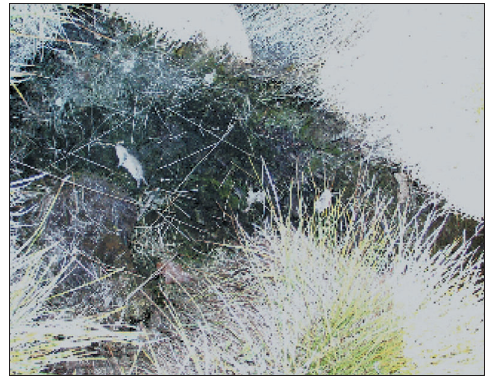
Fig. 1. Suffocated mouse inside dry vent.